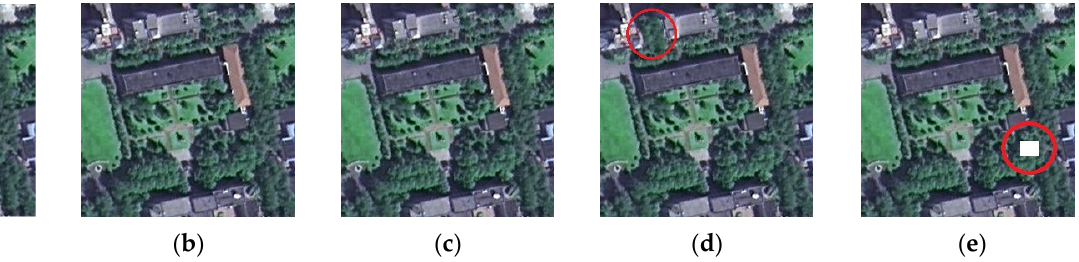
Figure 6. Examples of authentication for HRRS image: ( a ) Original TIFF format; ( b ) PNG format (TIFF format to PNG format); ( c ) watermark embedding (32 bits embedded in single band); ( d ) Tampering Example 1; ( e ) Tampering Example 2. Table 2. Hash sequences obtained by different hash algorithms.